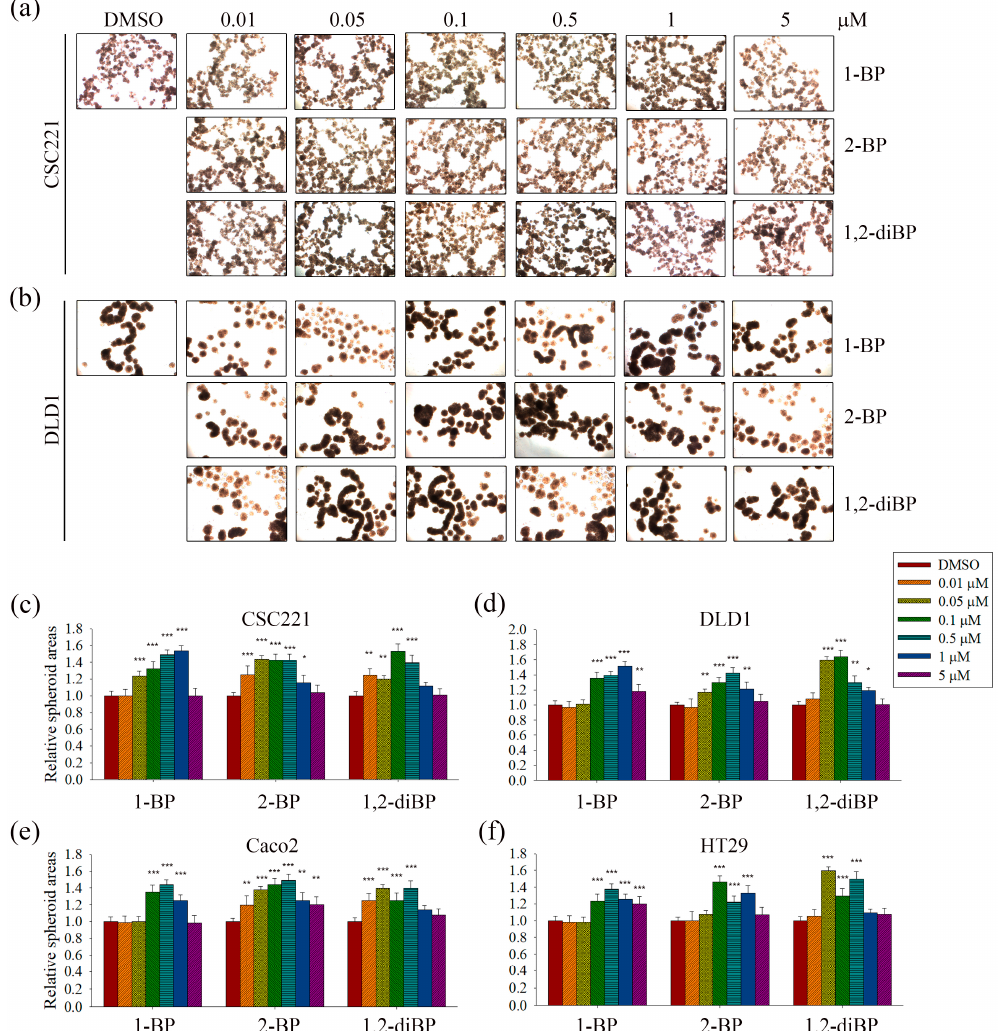
Figure 2. The effects of BP compounds on spheroid formation by CRC cells. CRC cells were treated with various concentrations of 1-BP, 2-BP, or 1,2-diBP for 72 h. After incubation, cells were detached from culture plates and seeded onto 24-well plates coated with a thin layer of 2% low-melting agarose. ( a , b ): Spheroid formation in CSC221 ( a ) and DLD1 ( b ) cells at the indicated concentrations; ( c – f ) Spheroid formation in CRC cells was calculated as described in Materials and Methods. Relative spheroid formation by each BP compound compared with the untreated control group for each cancer cell line is shown. Data represent the mean ± SEM, and analysis was performed by one-way ANOVA. * p < 0.05, ** p < 0.01, and *** p < 0.001 vs. the untreated control groups for each BP compound.